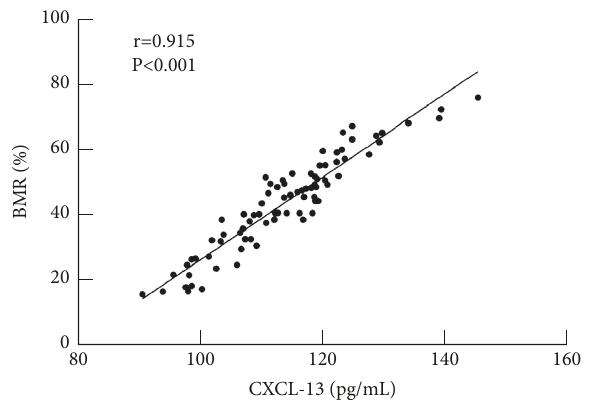
Figure 3: Scatter plot of correlation between the serum CXCL-13 level and BMR in patients.